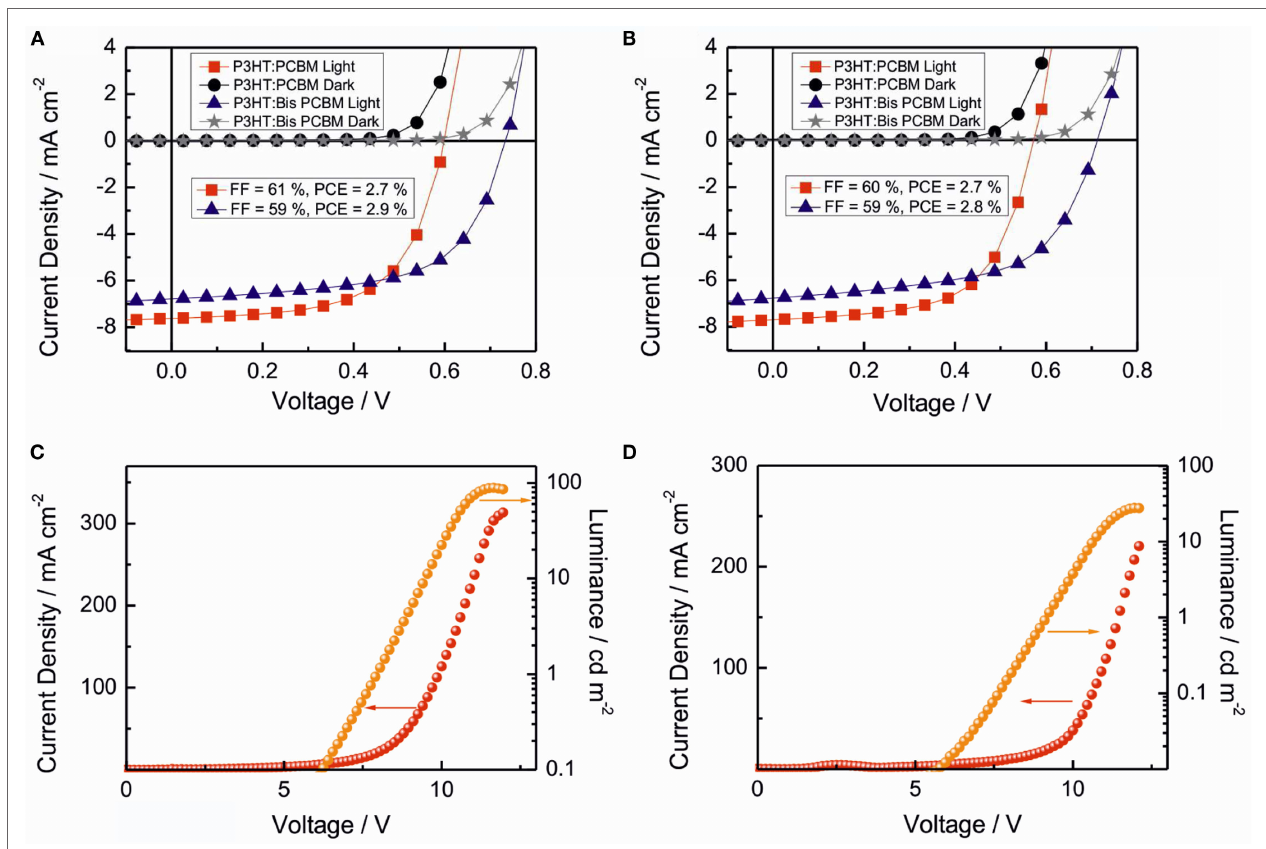
FigUre 5 | J–V characteristics of the OPVs: (a) glass/iTO/Pei/P3hT:PcBM or bis-PcBM/PeDOT:Pss/ag, (B) PeT/iTO/Pei/P3hT:PcBM or bis-PcBM/ PeDOT:Pss/ag and l–J–V characteristics of OleDs: (c) glass/iTO/Pei/aDs200re/PeDOT:Pss/ag, and (D) PeT/iTO/Pei/aDs200re/PeDOT:Pss/ag